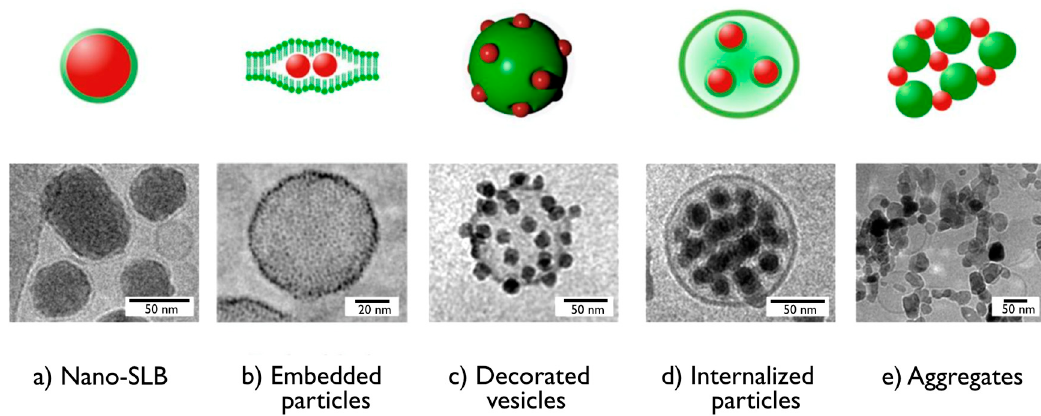
Figure 1. Cryogenic transmission electron microscopy images obtained from nanoparticle-vesicle association. ( a ) Silica nanoparticles coated with a supported lipid bilayer [17]; ( b ) gold particles embedded within the lipid membrane of a vesicle [31]; ( c ) silica particles adsorbed at the surface of a vesicle [30]; ( d ) silica particles internalized inside the lipid compartment [32]; ( e ) aggregates of ZnO nanoparticles and vesicles [18]. The upper panels provide an illustration for the different structures.